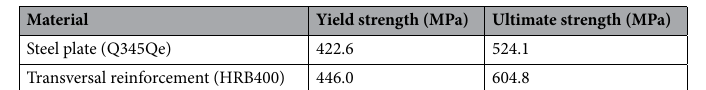
Table 3. Test results of material properties.